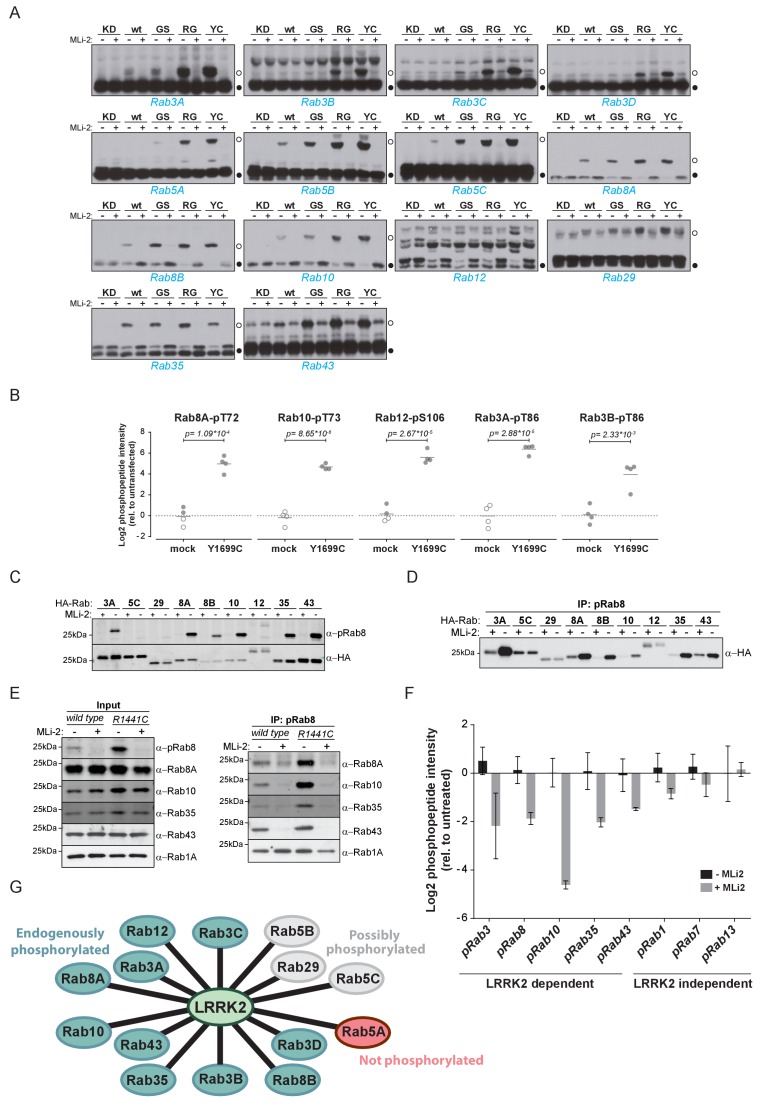
Ten endogenous Rabs are phosphorylated by LRRK2 in cells.(A) Phos-tag SDS-PAGE of 14 Rabs co-expressed with different LRRK2 variants (KD = kinase dead, wt = wild type, GS= G2019S, RG = R1441G, YC= Y1699C) in HEK293 cells. Filled circles indicate unmodified Rabs and open circles, phosphorylated forms (MLi-2 = 100 nM, 1 hr). (B) MS-quantified Rab3A-pT86, Rab3B-pT86, Rab8A-pT72, Rab10-pT73 and Rab12-pS106 peptide intensities from mock and LRRK2-Y1699C transfected cells. Open circles indicate imputed values. (C) Western blot analysis of HA-tagged Rabs co-expressed with LRRK2-Y1699C in HEK293 cells (-/+100 nM MLi-2, 2 hr) using polyclonal anti-phospho-Rab8 and HA antibodies. (D) Same as (C) but Rabs were immunoprecipitated using the anti-pRab8 antibody and HA antibody was used for detection. (E) Western blot of endogenous Rabs in wild type and LRRK2-R1441C MEFs (-/+100 nM MLi-2, 1 hr) using the indicated antibodies (left) and immunoprecipitation of Rabs using anti-pRab8 antibody (right). (F) MS-quantified Rab phosphosite intensities of pRab8 immunoprecipitation in R1441C MEFs (-/+100 nM MLi-2, 2 hr). Error bars are mean ±SEM (n = 3). (G) 10 Rab proteins at endogenous expression levels are phosphorylated by LRRK2 in cells (green). Rab5A is not (red) and Rab5B, Rab5C and Rab29 are possibly phosphorylated (grey).